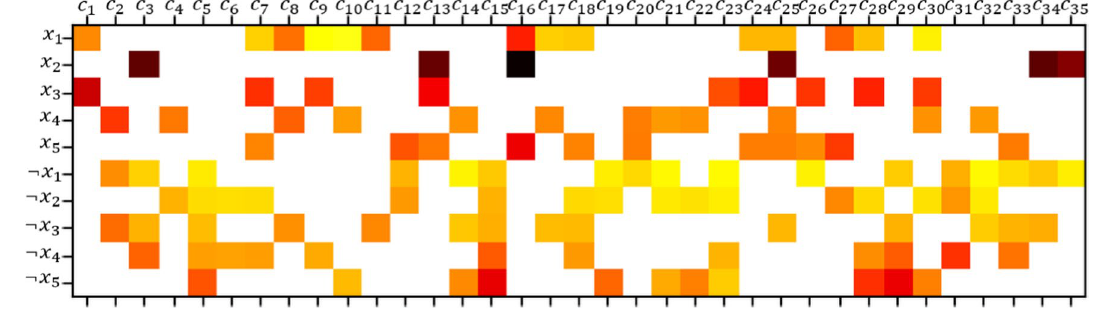
Fig. 7 The attention fraction visualization of literal nodes for neighboring clause nodes on a small problem Table 4 Results of the ablation study